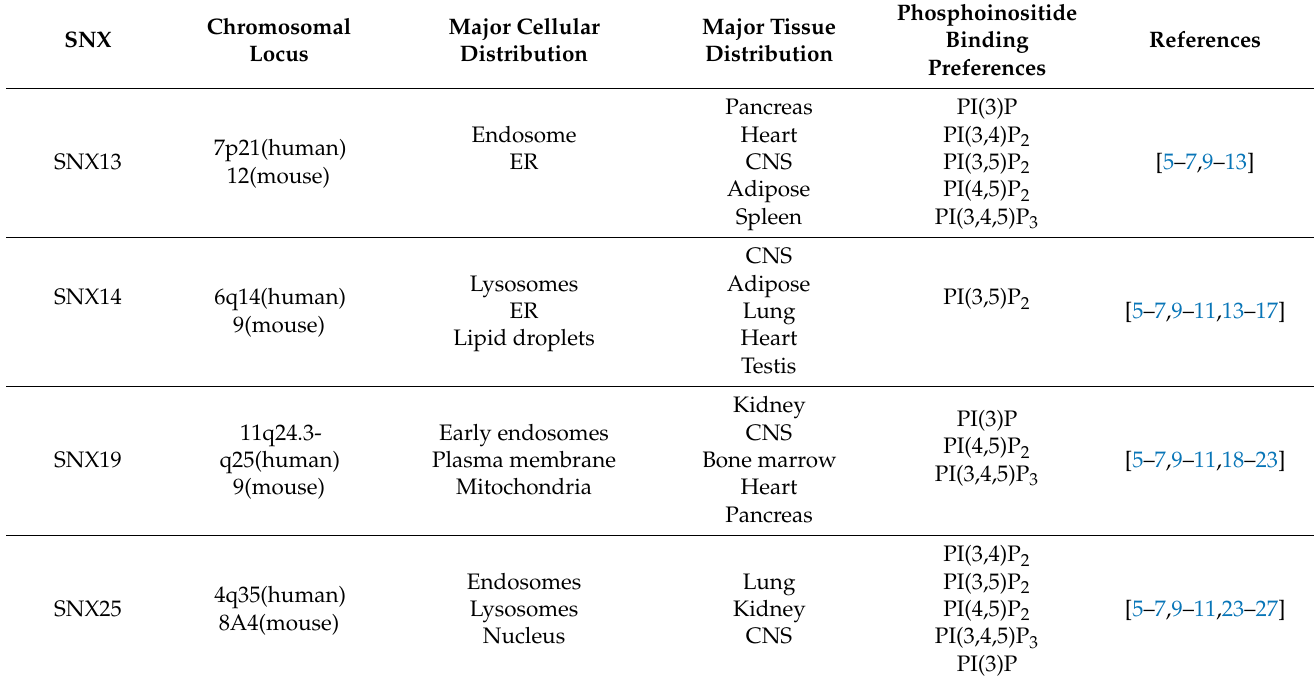
Table 2. Summary of the characteristics of SNX-PXA-RGS-PXC subfamily